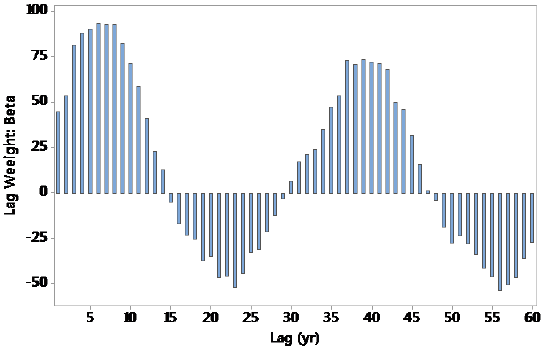
Figure 7: Distribution of the lag weights (Betas).